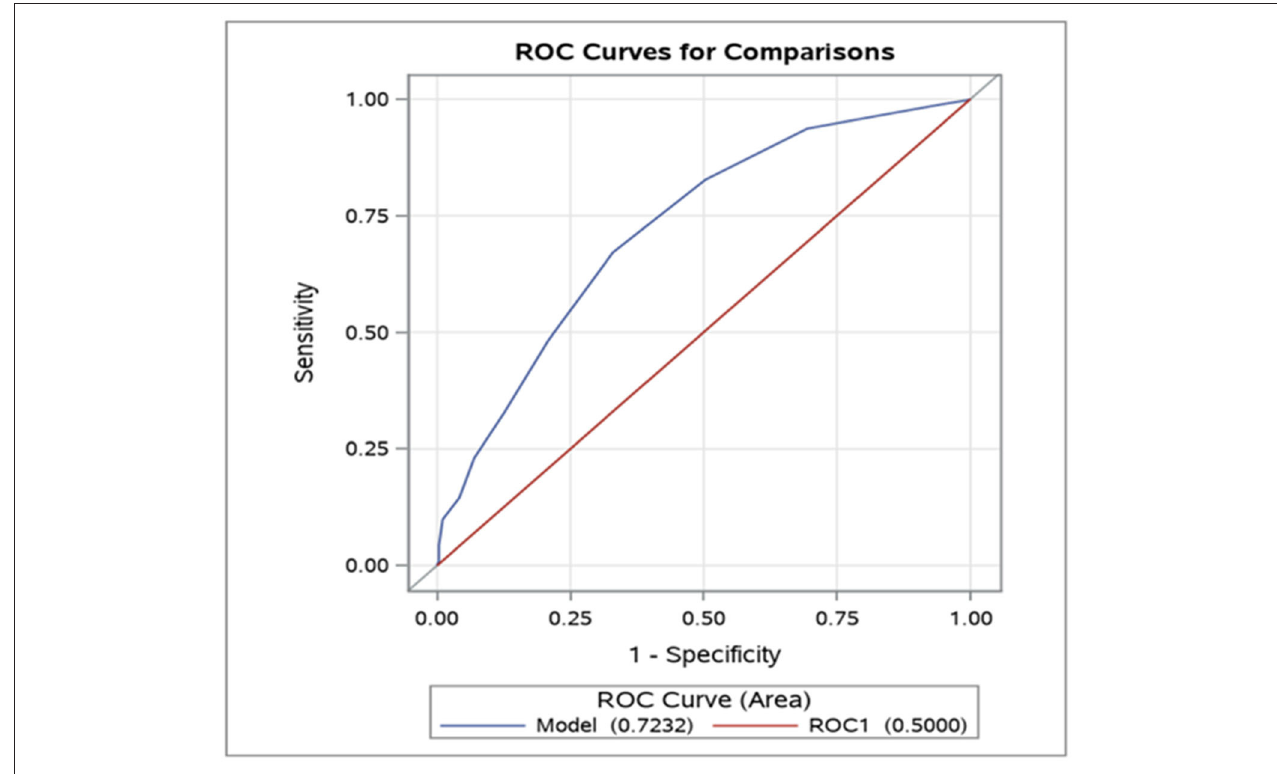
FIGURE 2 | Receiver Operating Characteristic (ROC) curve: predictive accuracy of the PANSS-FSNS (Positive and Negative Syndrome Scale Factor Score for Negative Symptoms) scale for differentiating minimally improved vs. clinically unchanged status. The values on the vertical and horizontal axis, respectively, depict the sensitivity (“true positive rate”) and 1 − specificity (“false positive rate”) values for the differentiation as a function of change from baseline in the PANSS-FSNS scale. The leftmost part of the ROC curve represents the highest empirically observed improvements in the sample as compared to baseline while the rightmost part represents no improvement (or even deterioration). Please note that the ROC curve for differentiating the minimally improved from the clinically unchanged status based on the PANSS-FSNS (ROC model, depicted in blue in the figure) significantly outperforms the random classification (ROC1 model, in red), with an area under the curve (AUC, labeled as “Area”) value of 0.7232 vs. 0.5000 ( p < 0.0001).